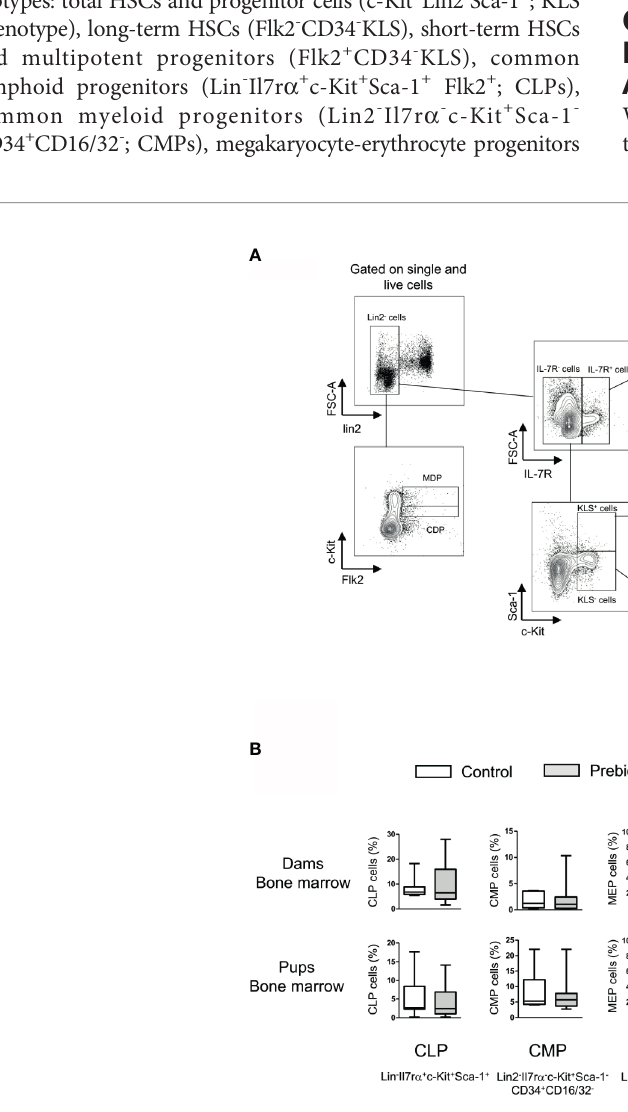
( Figure 3D ). In conclusion, GOS/inulin supplementation during gestation increased the level of acetate in the amniotic fl uid and the levels of other metabolites involved in lipid metabolism and energy production.